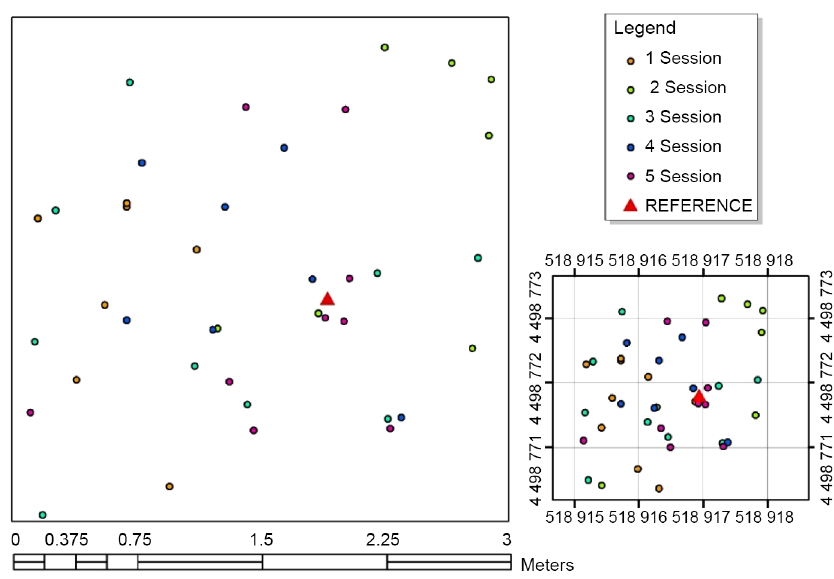
Figure 4. Spatial distribution of the points in different sessions on test site